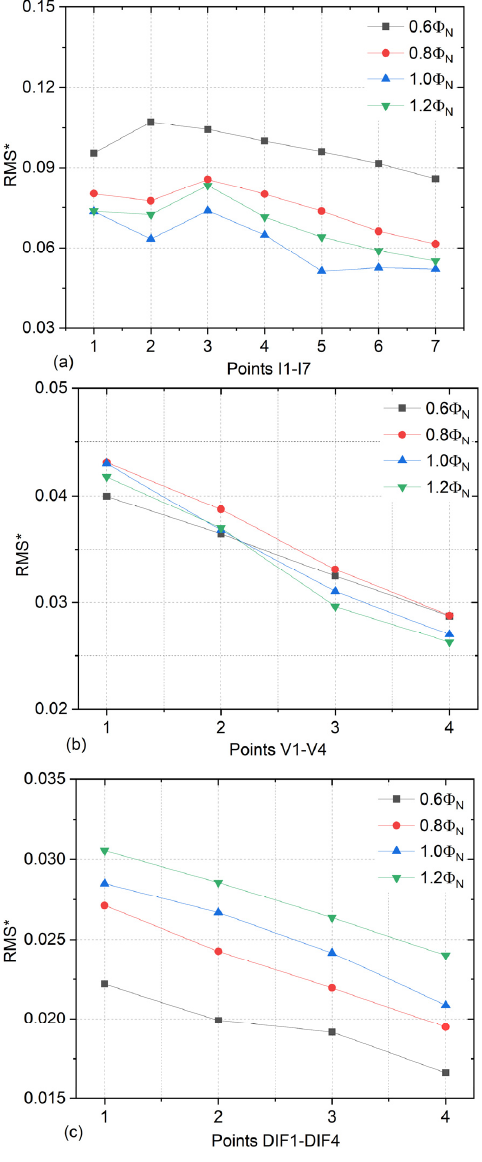
Figure 10. RMS * values for the measuring points by LDA experiments, ( a ) RMS values at points I1–I7, ( b ) RMS values at points V1–V4 and ( c ) RMS values at points DIF1–DIF4.